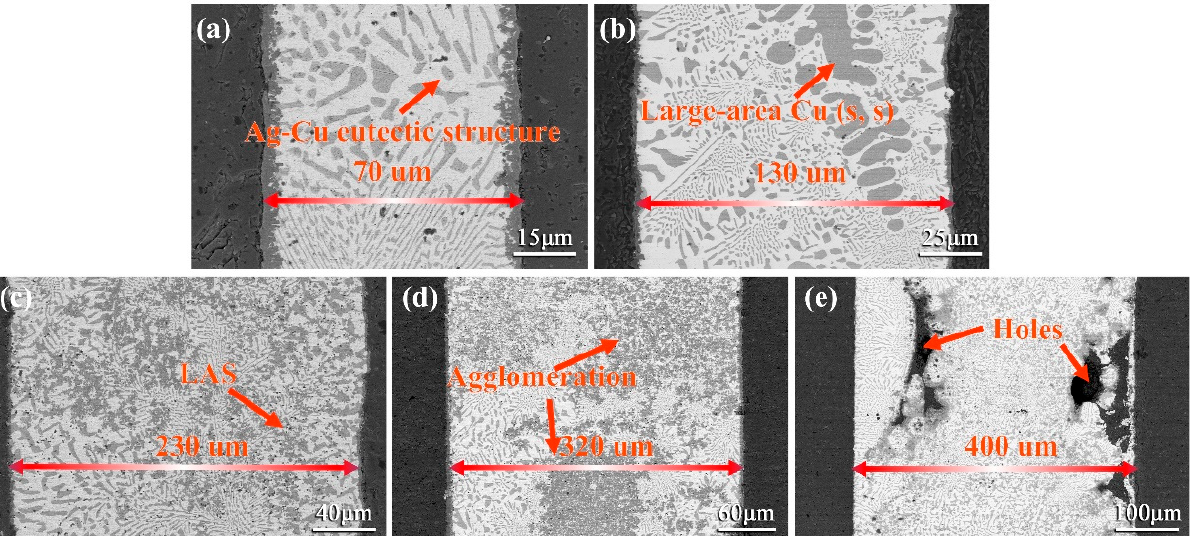
Figure 11. Typical overall morphology of the interface of SiC joints brazed with AgCuTi composite brazing filler at 900 °C for 10 min; ( a – e ) LAS additions of 0 wt%, 0.5 wt%, 1 wt%, 2 wt%, and 3 wt%, respectively.